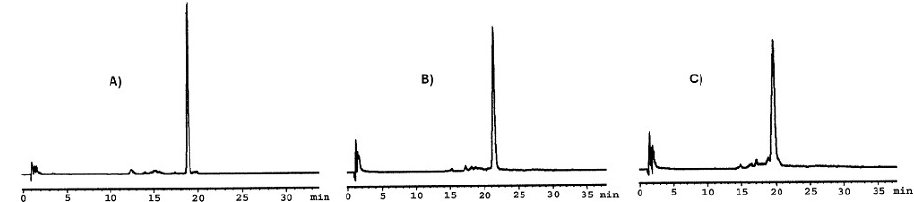
Figure 5. HPLC analysis of hybrids 14 ( A ), 24 ( B ), and 25 ( C ). Column: Zorbax SB-C18, 3.5 μm; 2.1 × 30 nm; gradient: ( A ) from 50% to 100% acetonitrile in water within 15 min, 100% acetonitrile within 15 min; ( B ) from 20% to 100% acetonitrile in water within 30 min; ( C ) from 20% to 100% acetonitrile in water within 30 min; flow rate: 0.4 mL/min; detection at 265 nm.